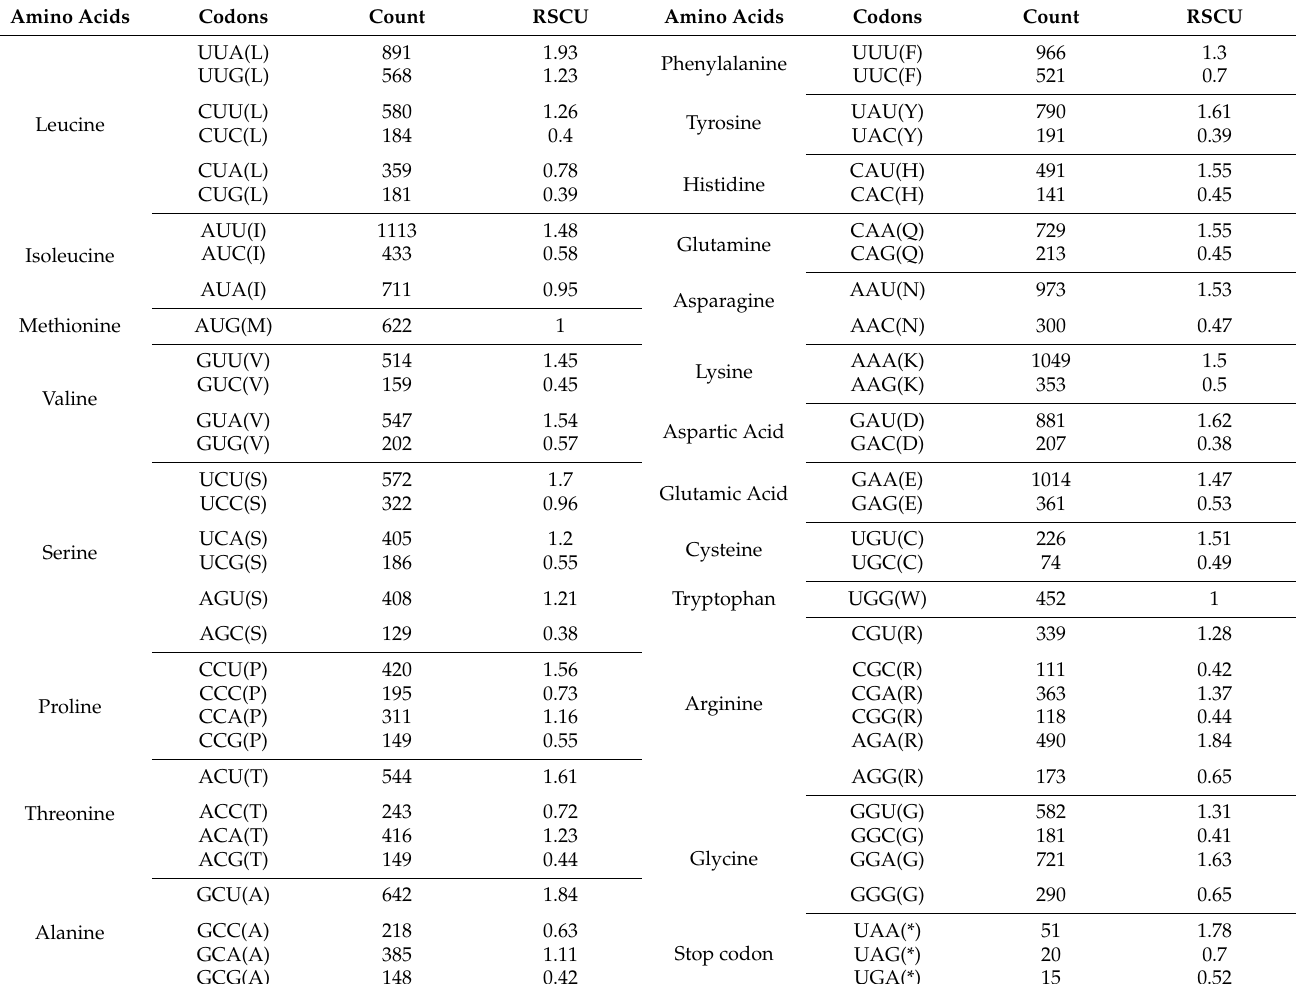
Table 3. Codon usage in the chloroplast genome of P. fortuneana